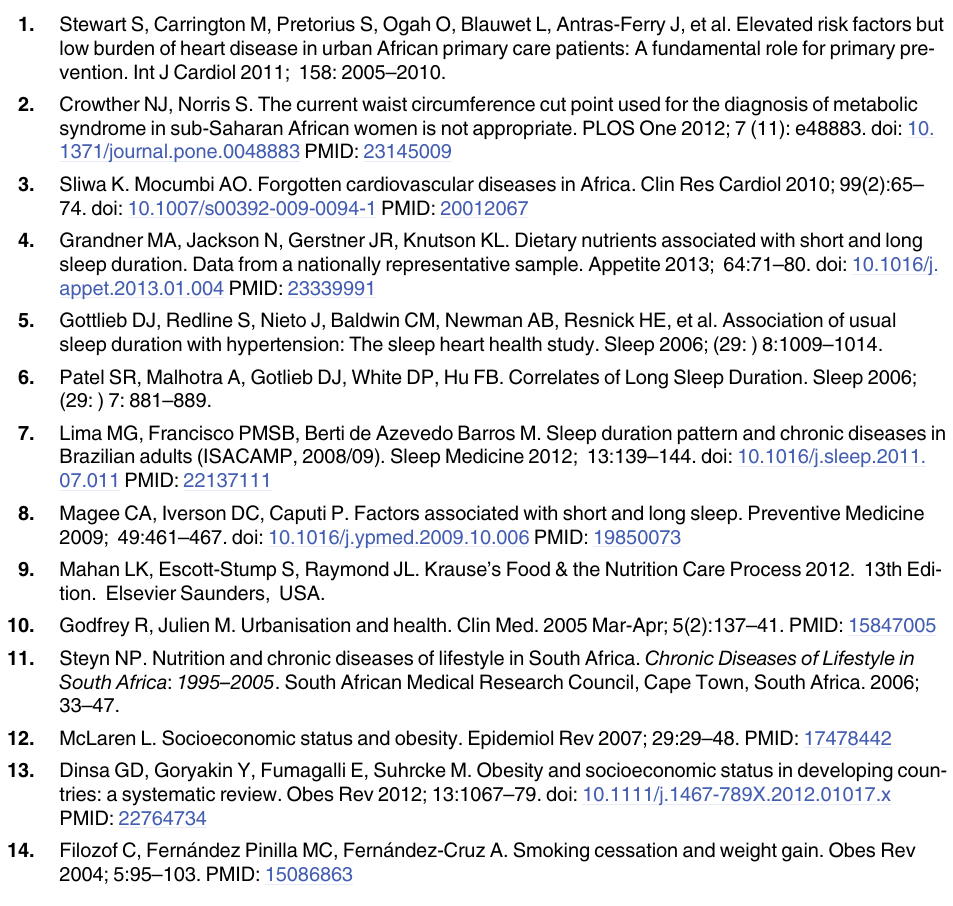
S1 Fig. The effect of environmental tobacco smoke exposure on BMI in males (n = 424; grey filled bars) and females (n = 829; open bars). The data is given as median with inter- quartile range; (cid:4) p < 0.05, (cid:4)(cid:4) p < 0.01, (cid:4)(cid:4)(cid:4) p < 0.001 versus none; + p < 0.05 versus 1 – 6 times/week. (TIF) S2 Fig. The effect of night time sleep duration on BMI in females < 40 years-of-age (n = 414; light grey filled bars) and females (cid:1) 40 years-of-age (n = 409; dark grey filled bars). The data is given as median with inter-quartile range; (cid:4) p < 0.05 versus < 8 hours.